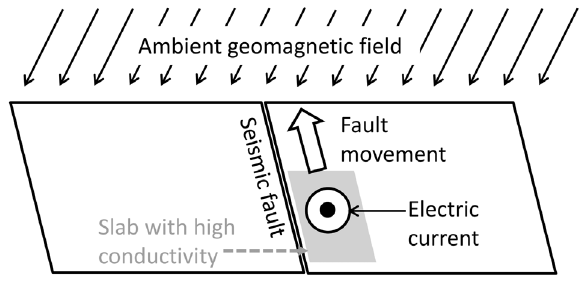
Figure 1. A schematic illustration of the subsurface-current generat- ing mechanism analyzed in this paper. Seismic motion of a fault block containing a zone with high conductivity subject to the ambient geo- magnetic field induces an electric current according to Faraday’s law.